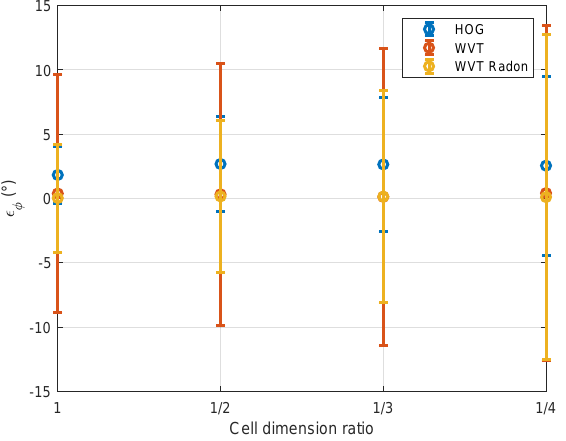
Figure 12. Error mean and standard deviation in function of cell dimensions for a sea surface exposed to a 10 m / s wind